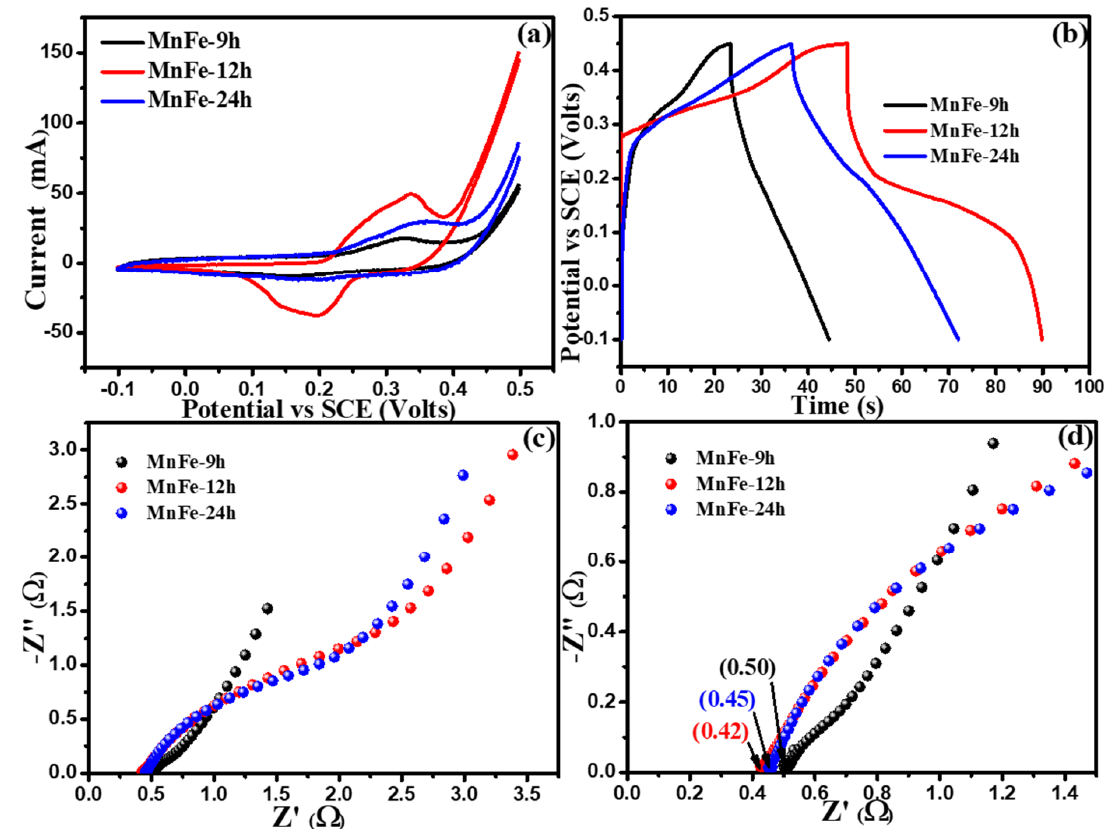
Figure 5. ( a ) Cyclic voltammetry (CV) curves of MnFe-9h, MnFe-12h, and MnFe-24h, at a scan rate of